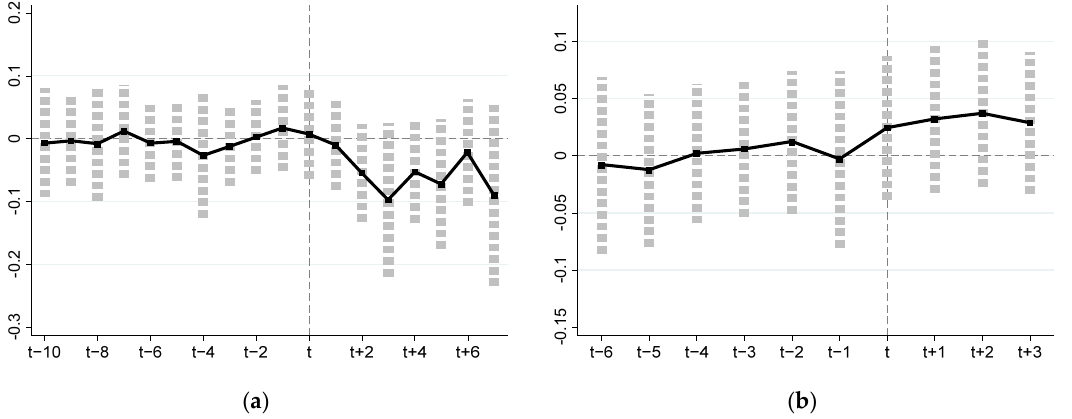
Figure 3. Spatial evolution of MGP from 1997 to 2019. ( a ) Parallel trend test before and after TPSP implementation; ( b ) parallel trend test before and after PSP implementation Note: The abscissa represents the time dummy variables, and the ordinate represents the coefficient estimates of the time dummy variables.